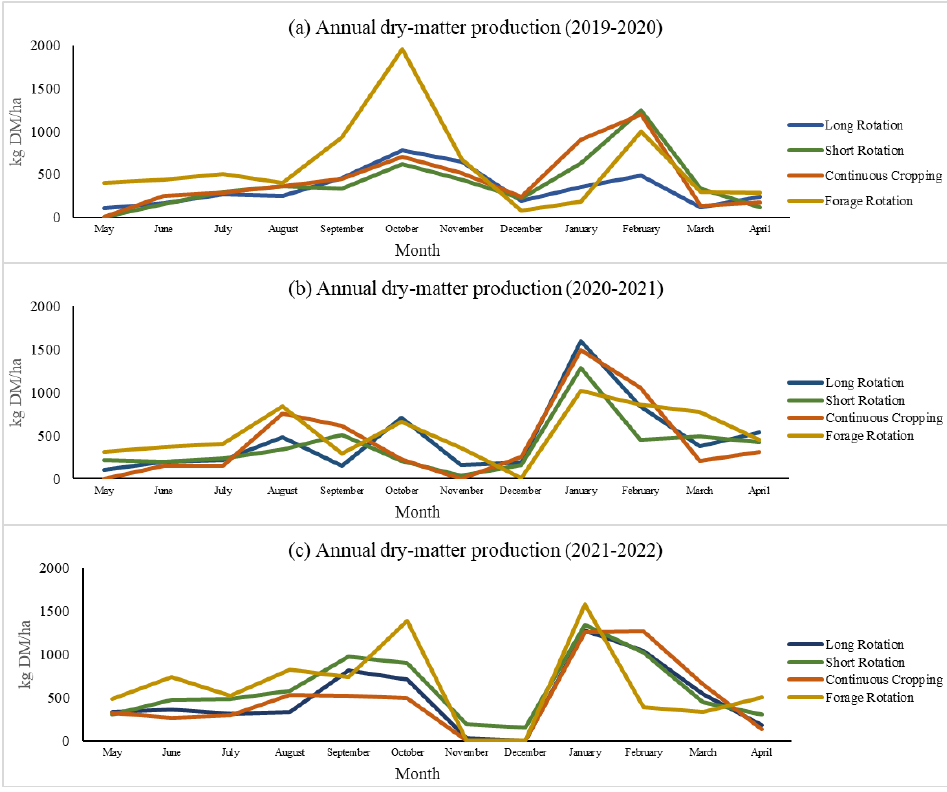
Figure 4. Distribution of dry-matter (DM) production (kg DM/ha) in the ‘Palo a Pique pasture–crops rotations long-term experiment in Treinta y Tres, Uruguay ( a ) Year 1 (2019 – 2020); ( b ) Year 2 (2020 – 2021) and ( c ) Year 3 (2021 – 2022).